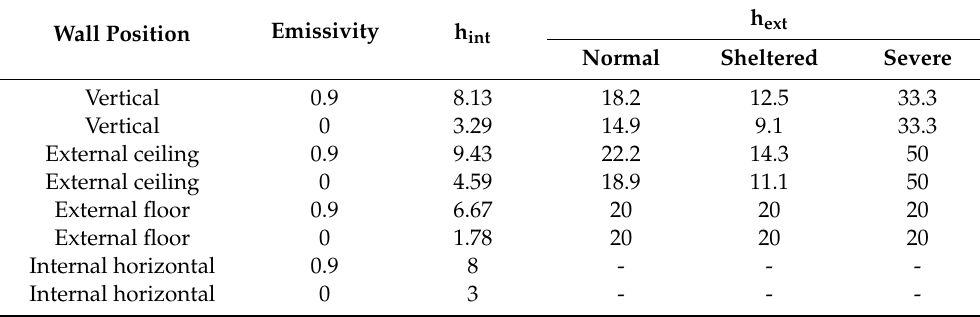
Table A4. Coe ffi cient of internal and external